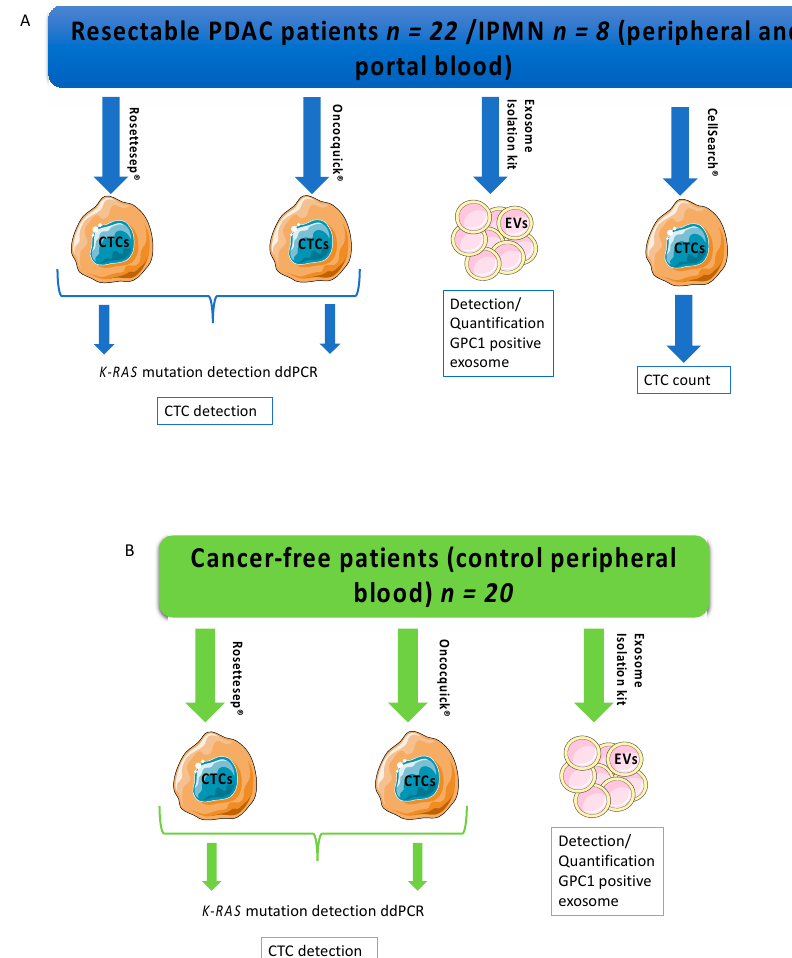
Figure 1. Study design, blood samples, and liquid biopsy methods. ( A ) Pancreatic ductal adenocarcinoma (PDAC) patients and patients with IPMN had both peripheral and portal samples for CTC-enrichment detection/count and quantification of GPC1-positive exosomes (blue rectangle and arrows). ( B ) Control group had peripheral samples for CTC-enrichment detection (RosetteSep TM ) and quantification of GPC1-positive exosomes (green rectangle and arrows). Abbreviations: EVs: extracellular vesicles; CTC: circulating tumor cell; IPMN: intraductal papillary and mucinous neoplasm; GPC1: Glypican 1.